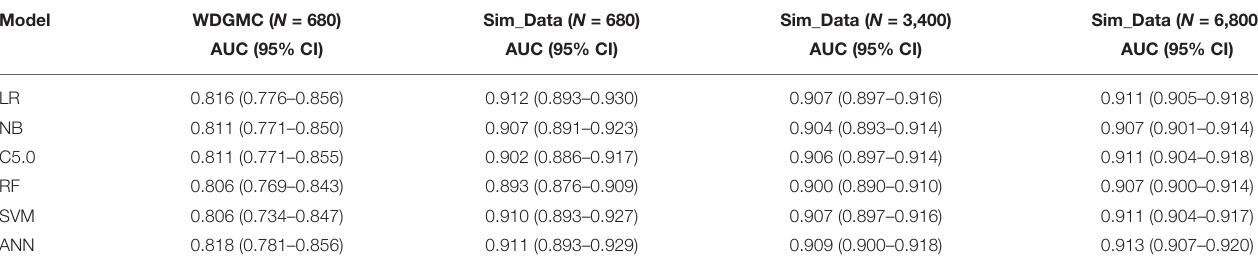
TABLE 5 | AU-ROC performance scores (with confidence interval) examining the consistency of the predictive models from the WDGMC CRC survival data and across the three simulated datasets used for model validation.